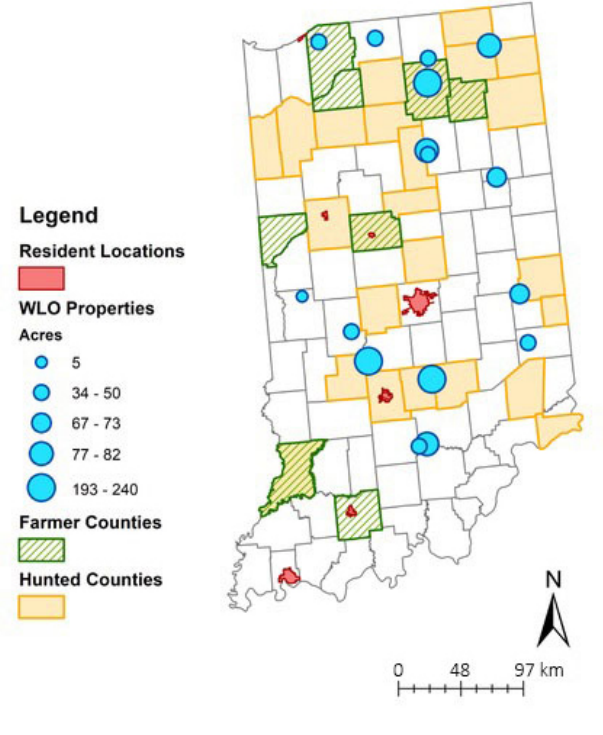
Fig. 2 . Counties and locations across Indiana represented by interview participants from four deer stakeholder